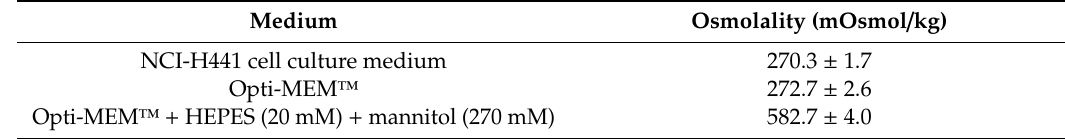
Table 4. The osmolality of cell culture and transfection